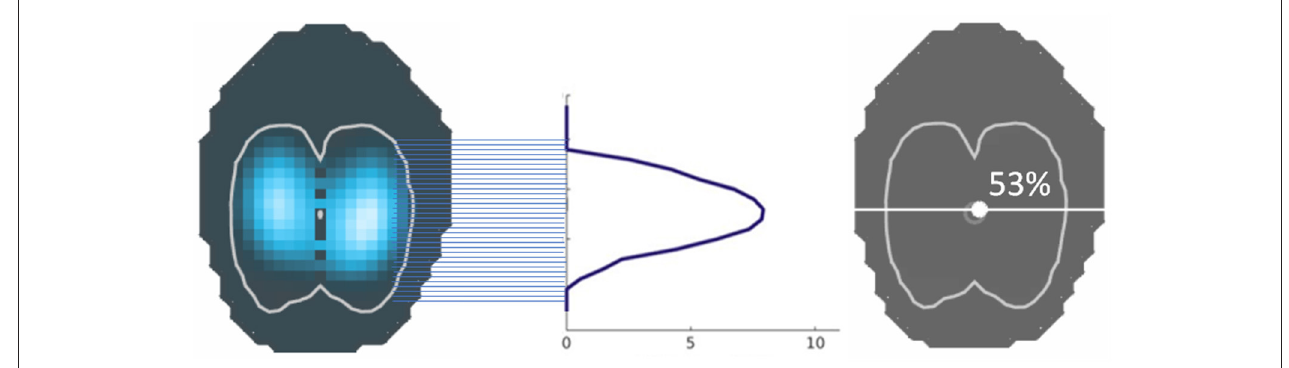
FIGURE 11 | The centre of ventilation is calculated from the sum of impedance on a given pixel line, divided by the sum of all impedance, and given as a percentage. This can be performed in both the horizontal and vertical axes.